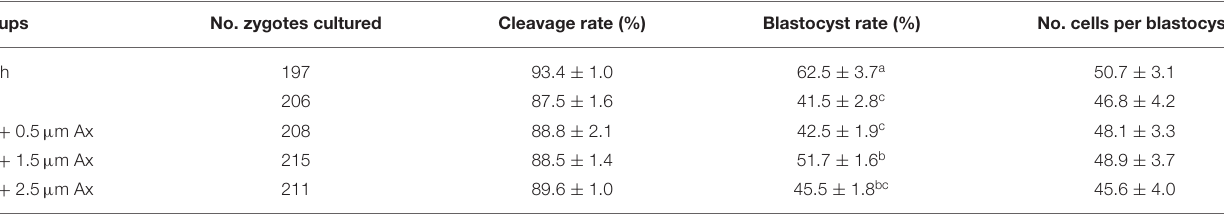
TABLE 1 | Effects of astaxanthin (Ax) supplementation (0.5, 1.5, and 2.5 µ m) on developmental competence of vitrified zygotes derived from parthenogenetic activation. Groups